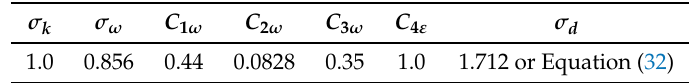
Table 3. Empirical coefficients for the modified k − ε turbulence model.